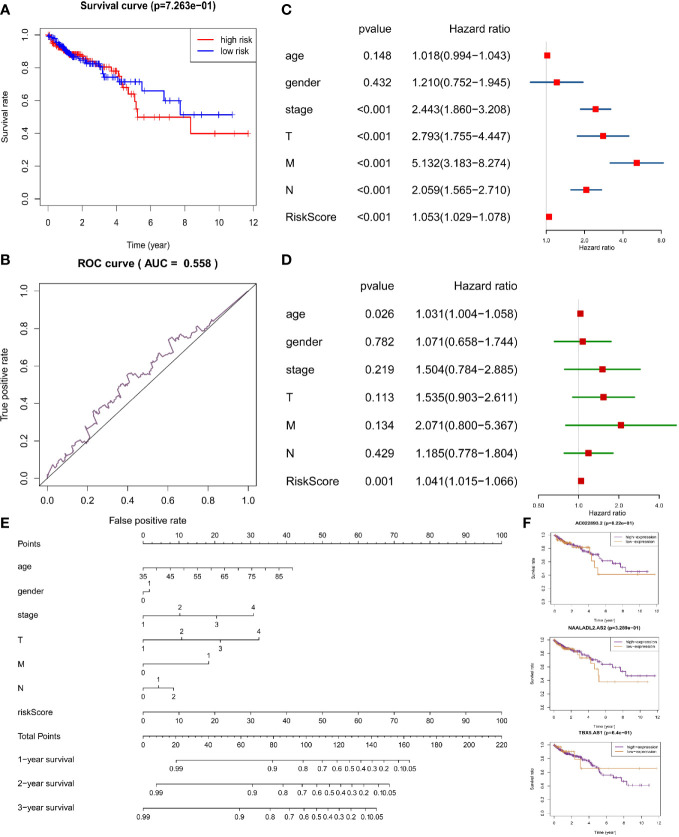
Risk prognosis model verification of three prognostic risk-related DAR-lncRNAs in TCGA data. (A) Survival curve comparing high-risk and low-risk groups by R package “survival”. (B) ROC curve of risk prognosis model in the verification set by R package “survivalROC”. (C) The univariate cox forest map of clinical characteristics in the verification set by R package “survival” and “forestplot”. (D) The multivariate cox forest plot of clinical characteristics in the verification set by R package “survival” and “forestplot”. (E) The nomogram baseline of multivariate cox analysis by R package “rms”. (F) The survival curve of three prognostic risk-related DAR-lncRNAs by R package “survival”.